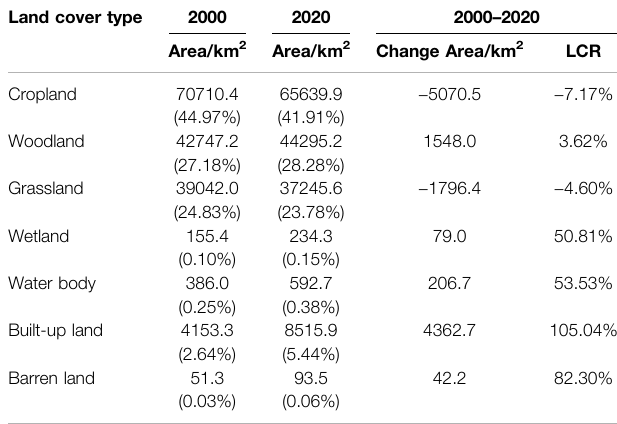
TABLE 1 | Areas and changes of land cover types from 2000 to 2020 in study